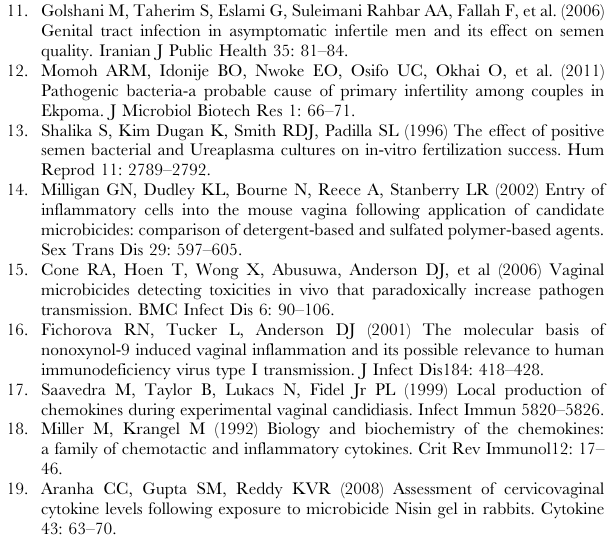
Figure S3 Standard curve for IL-10. Figure S4 Standard curve for TNF- a